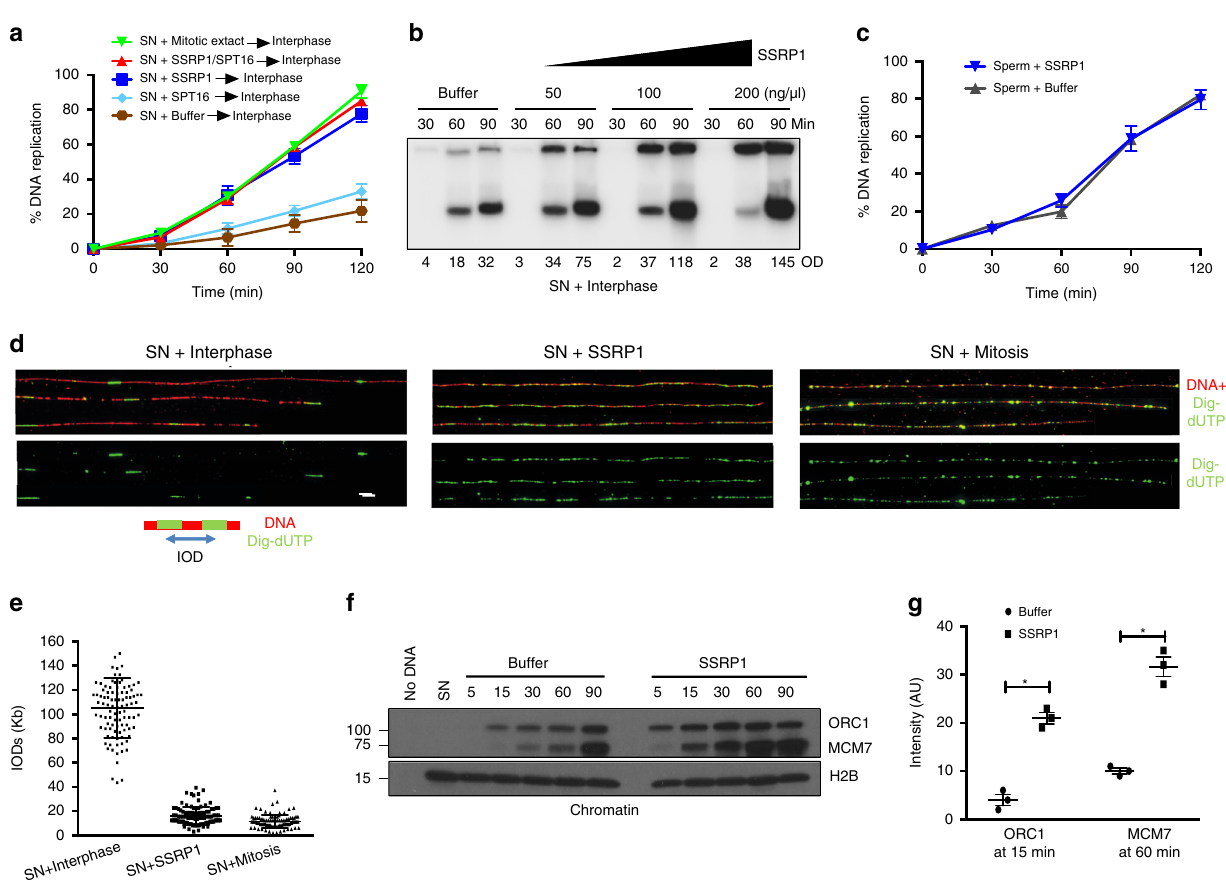
Fig. 2 SSRP1-dependent stimulation of replication origin assembly. a Graph showing replication time course of SN (4000 n/ μ l) replication. SN were pre- incubated for 30 min with buffer, 200 ng/ μ l recombinant SSRP1, SPT16 or both, as indicated, and transferred to interphase extracts (Interphase) or pre- incubated in CSF-arrested mitotic egg extract for 30 min (Mitotic) then driven into interphase by CaCl 2 addition. Each point represents the mean ± SEM. n = 3 independent experiments; p < 0.0001 when comparing mean values for all samples; Two-way anova. b Representative autoradiography of a DNA replication time course assay in interphase egg extract showing α - 32 P-dCTP incorporation in SN. Optical density (OD) for each lane is indicated. c Graph showing replication time course of sperm nuclei (8000 n/ μ l) treated as indicated. Each point represents mean ± SEM. n = 3 independent experiments; p = ns when comparing mean values for all samples; Two-way anova. d DNA fi ber assay showing digoxigenin-dUTP (dig-dUTP) incorporation in SN incubated directly in interphase egg extract together with buffer (left), pre-incubated with 200 ng/ μ l recombinant SSRP1 (center) or pre-incubated for 30 min in CSF- arrested mitotic egg extract then driven into interphase by CaCl 2 addition (right). DNA fi bers are in red. Dig-dUTP labeled tracts are in green. Bar = 10 Kb. e Graphs showing IODs indicated in Kb for each sample. The center-to-center distances between adjacent Dig-dUTP tracks were measured and plotted analyzing 50 fi bers pooled from three independent experiments; IODs and mean values ± SEM are shown; n = 100 individual IODs; p < 0.0001; Two-way anova. f Chromatin binding showing somatic nuclei incubated in interphase extract in the presence of buffer or recombinant SSRP1. Chromatin was isolated at the indicated times after addition to egg extract and blotted using the indicated antibodies. No DNA indicates absence of nuclei. SN indicates somatic nuclei alone. Image shows typical result. g Graph showing relative quanti fi cation of signal intensity of ORC1 and MCM7 proteins loaded on chromatin at the indicated times normalized to histone H2B. Bars represent mean intensity ± SEM. n = 3 independent experiments; p < 0.0005 when comparing mean values for ORC1 and MCM7; t